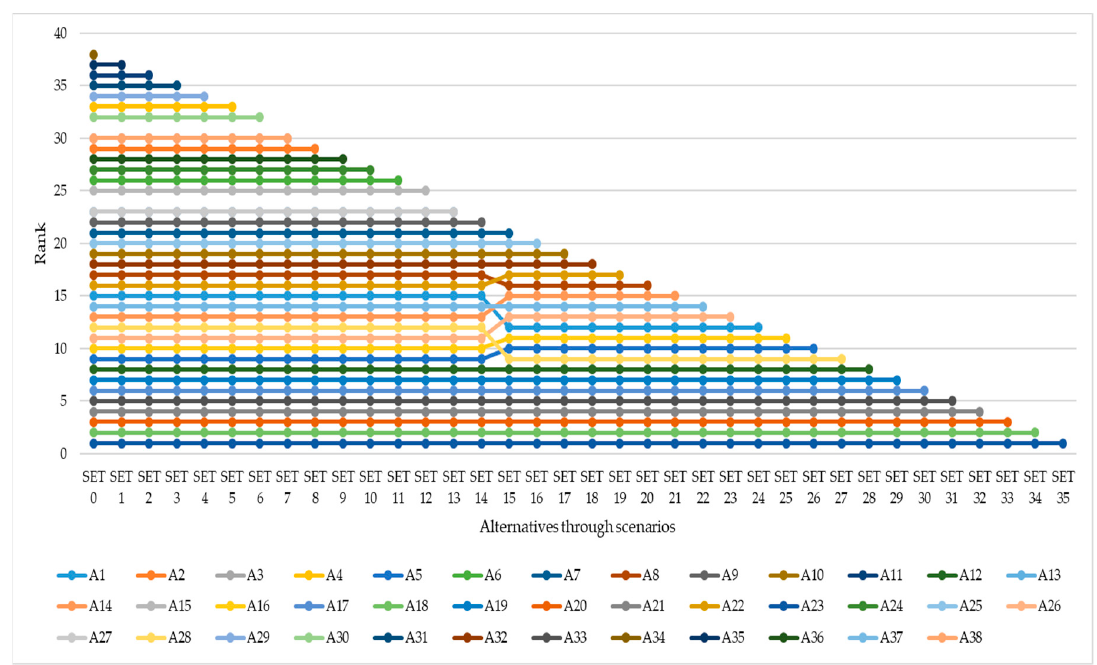
Figure 5. Results of the test of reverse rank matrix.